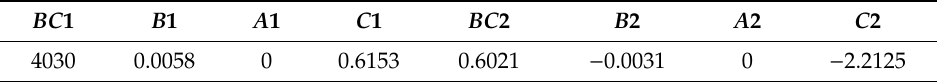
Table 7. Values of the material model coe ffi